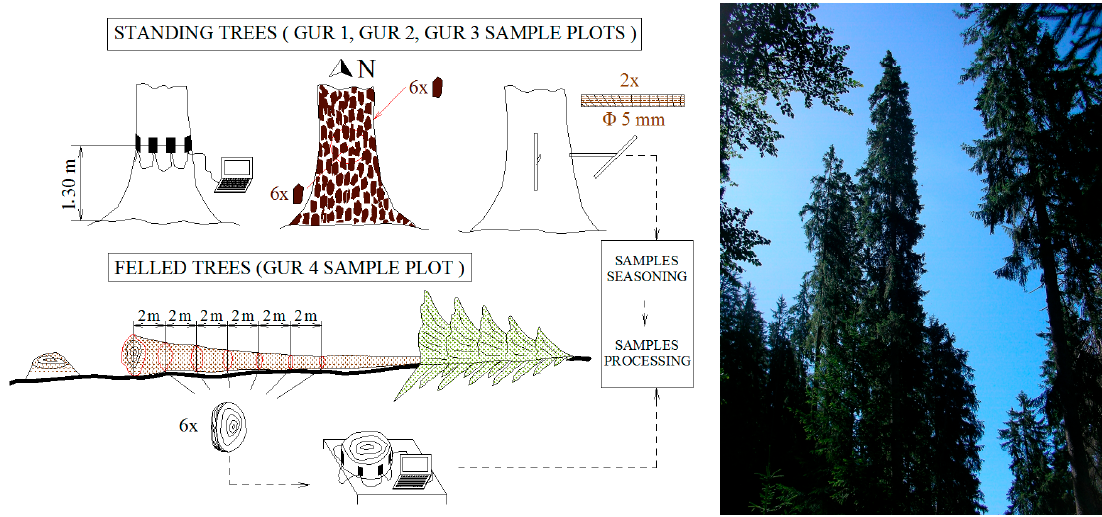
Figure 2. Scheme of the sampling design and outlook of one of the sample sites.